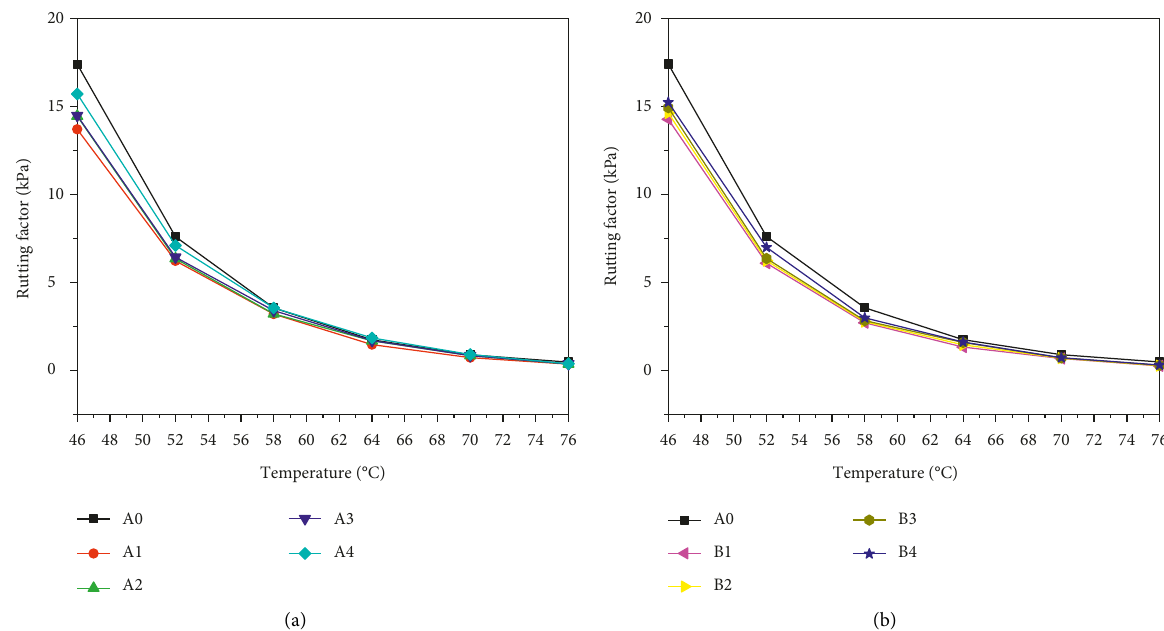
Figure 9: Rutting factors of GOMBA at different dosage levels. (a) Effects of different GO dosages on the rutting factor of bio-asphalt A and (b) effects of different GO dosages on the rutting factor of bio-asphalt B.